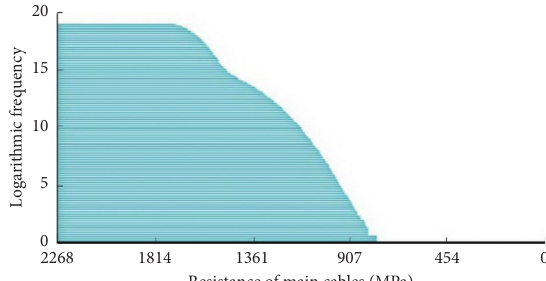
Figure 11: Logarithmic frequency of resistance after a 40-year operation.